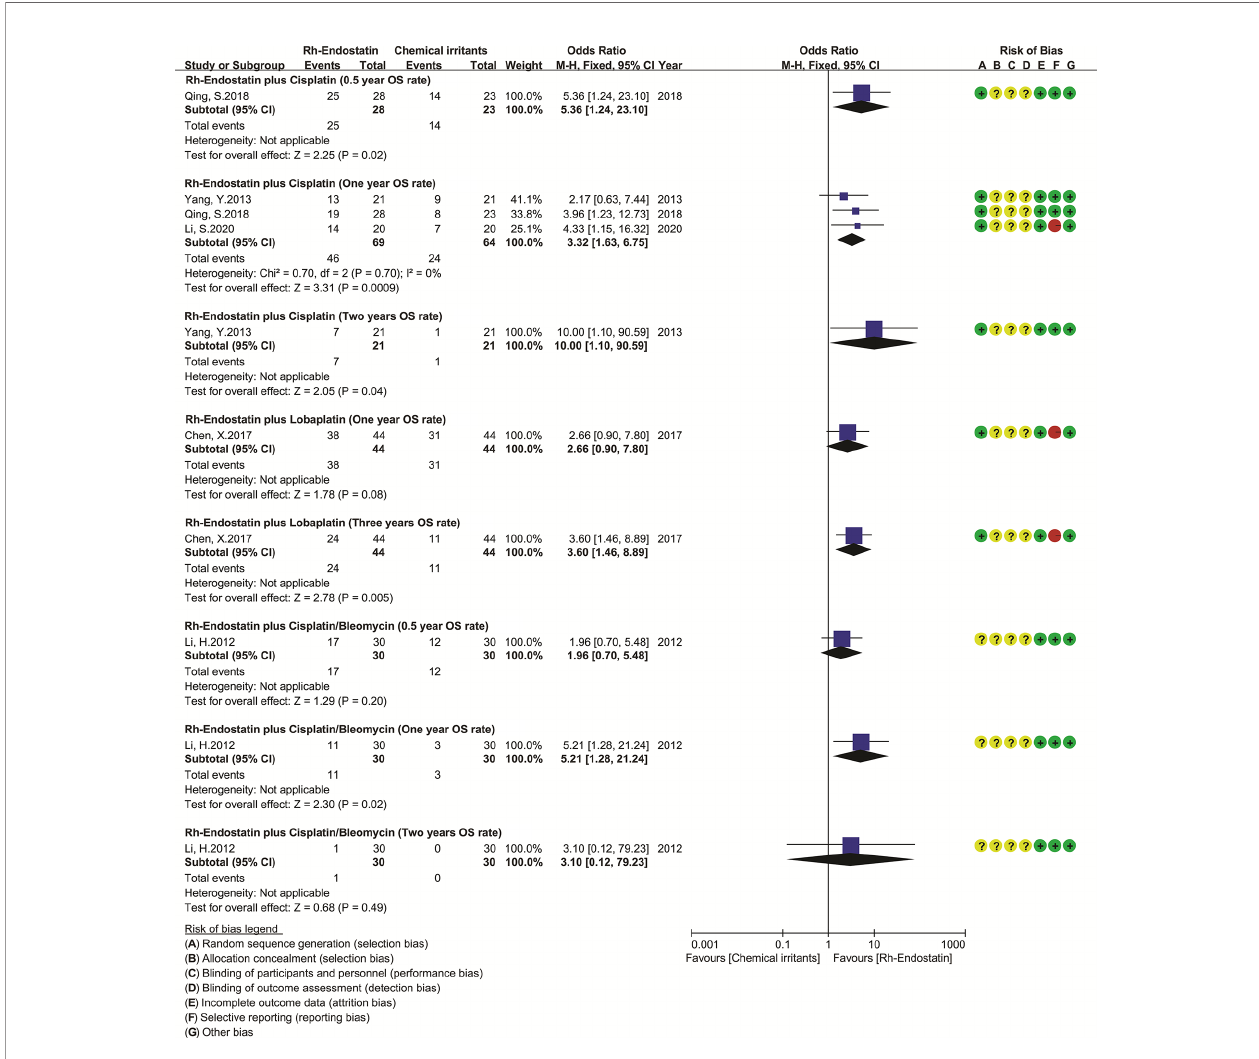
FIGURE 4 | The forest plot of overall survival. DDP, cisplatin; LBP, lobaplatin; BLM, bleomycin; OS, overall